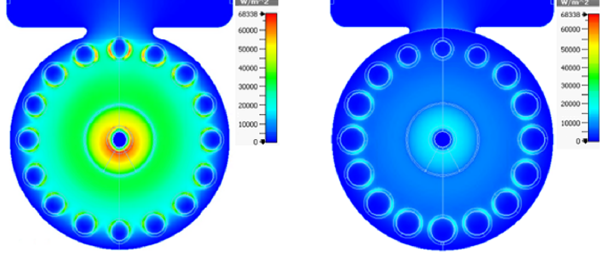
FIG. 4. Variation of S in the nominal output cell (left) where c the power is fed in the tested direction and the nominal input cell (right).